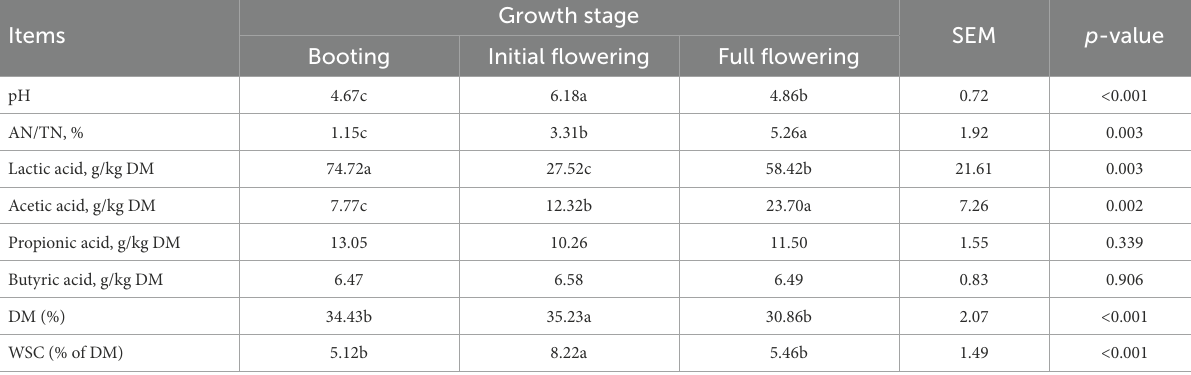
TABLE 2 Silage quality of ryegrass silage at different growth stages.